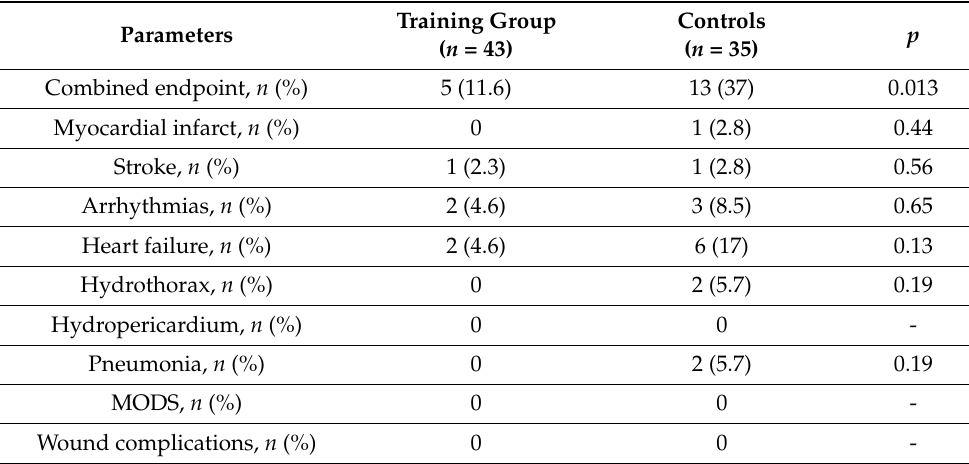
Table 3. Postoperative complications of patients after coronary bypass surgery according to the prehabilitation